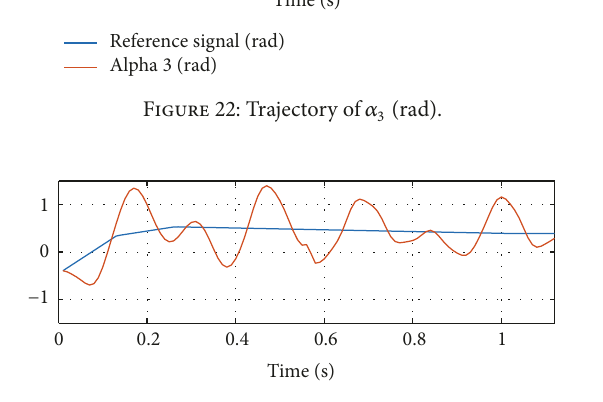
Figure 23: Trajectory of 𝛼 4 (rad).